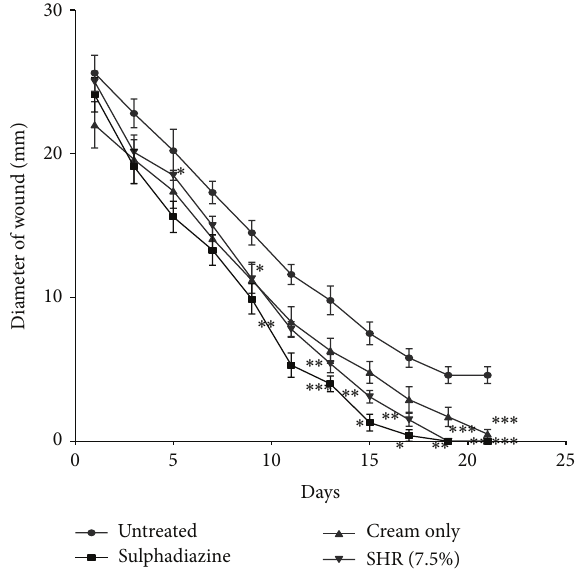
Figure 9: Influence of methanol root extract (SHR) cream (7.5% w/w) of S. hispidus on the rate of closure of wounds. Values are diameter of wounds expressed as mean ± SEM ( 𝑁 = 5 ). ∗ 𝑃 < 0.05 , ∗∗ 𝑃 < 0.01 , and ∗∗∗ 𝑃 < 0.001 . Control is the untreated wounds; 1% w/w silver sulphadiazine was used as positive